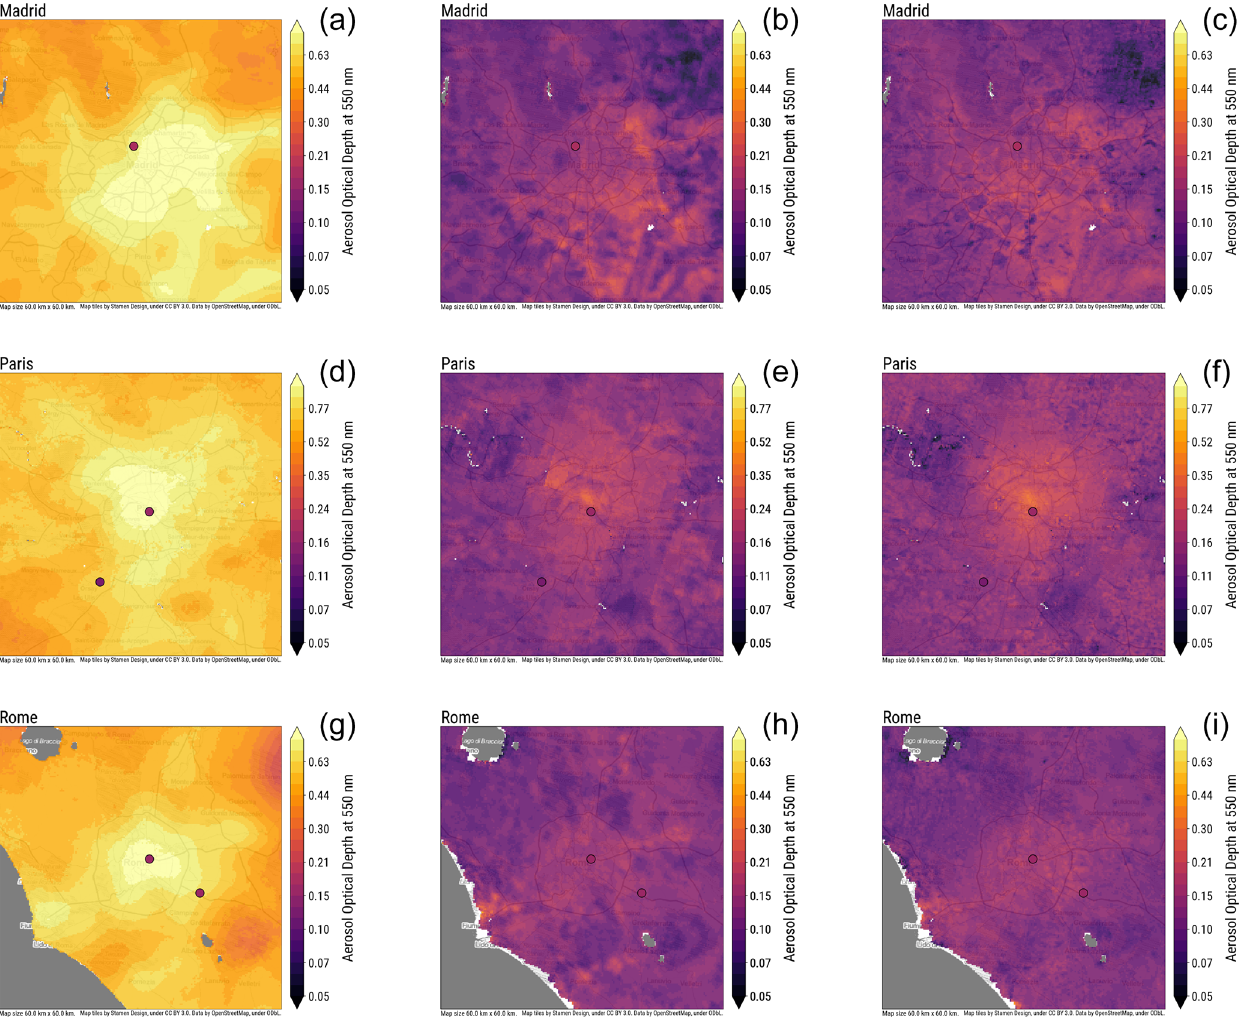
Figure 8. July 2019 monthly averages of AOD at 550nm for Madrid (a, b, c) , Paris (d, e, f) and Rome (g, h, i) . (a, d, g) Sentinel-3 Level-2 Synergy. (b, e, h) fully learned regressor model. (c, f, i) Corrected Sentinel-3 Synergy. Circles represent the monthly averages of AERONET